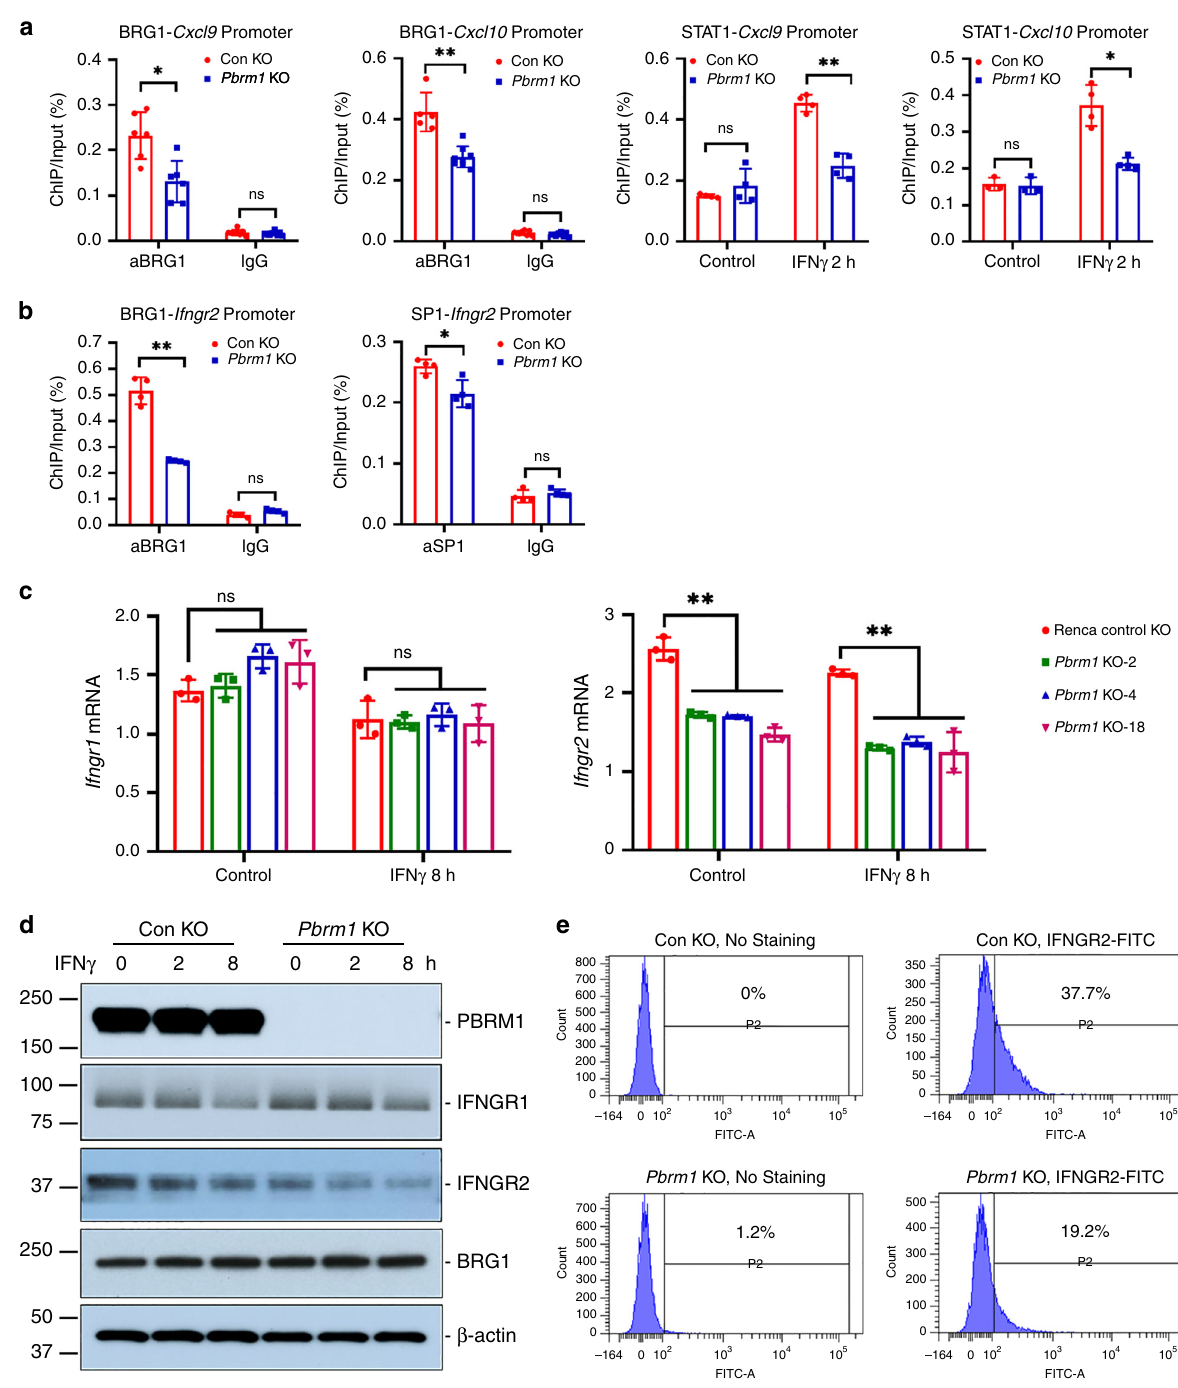
Fig. 2 Pbrm1 knockout reduced Ifngr2 expression in Renca cells. a BRG1 and STAT1 binding to Cxcl9 and Cxcl10 promoter in Renca cells. b BRG1 and SP1 binding to Ifngr2 promoter. Chromatin immunoprecipitation (ChIP) with BRG1, STAT1 or SP1 antibody as indicated in fi gures was performed using SimpleChIP ® Plus Enzymatic Chromatin IP Kit. Isotype IgG was used as negative control. Immunoprecipitated DNA was ampli fi ed and quanti fi ed by real- time PCR. Protein relative occupancy on promoter was expressed as a percent of the total input chromatin. Con KO or Pbrm1 KO Renca cells were treated with 1 ng/ml IFN γ for 2 h for IFN γ -induced STAT1 binding to Cxcl9 or Cxcl10 promoter. c IFN γ receptor subunits, Ifngr1 and Ifngr2 , mRNA expression detected by real-time PCR. Gapdh was used as internal control. d IFN γ receptor subunits, IFNGR1 and IFNGR2, protein expression was detected by western blot. β -actin was used an internal control. e IFNGR2 membrane expression was detected by fl ow cytometry. Unpaired t -test was performed with GraphPad Prism 7.03. * P < 0.05 and ** P < 0.001, compared with control knockout cells. Data in the bar graphs represent mean ± S.D. Source data are provided as a Source Data fi